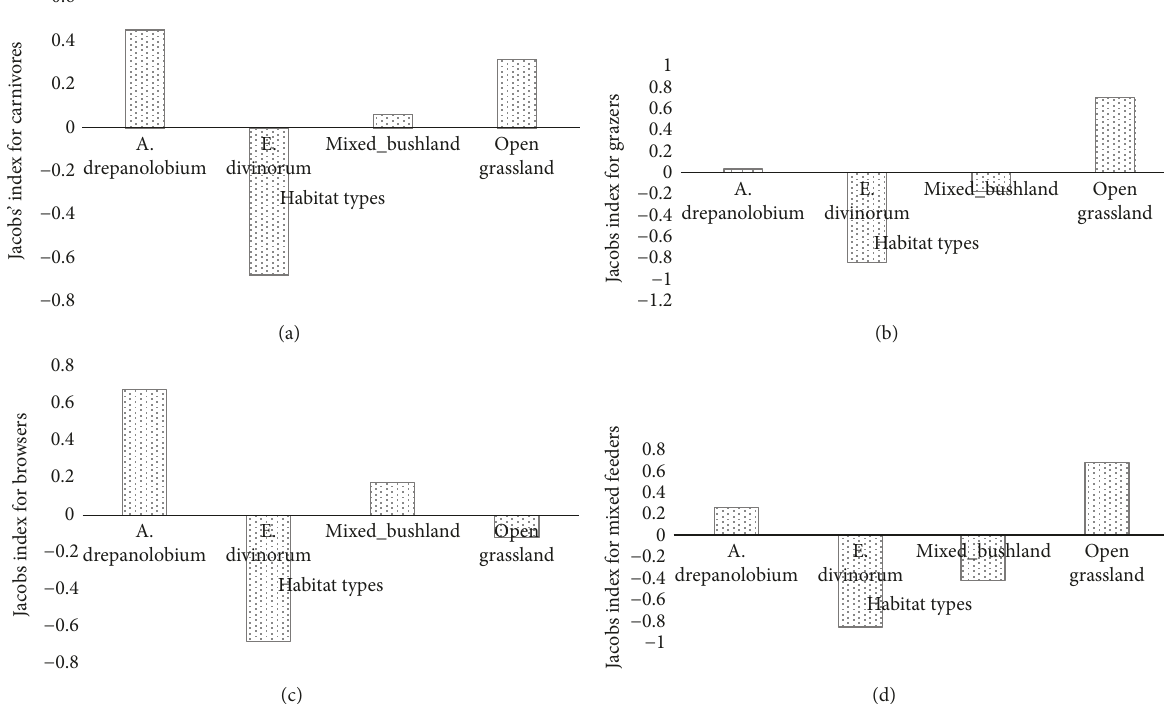
Figure 4: Habitat preference or avoidance (Jacobs’ index) for (a) carnivores, (b) grazers, (c) browsers, and (d) mixed feeders in OPC.